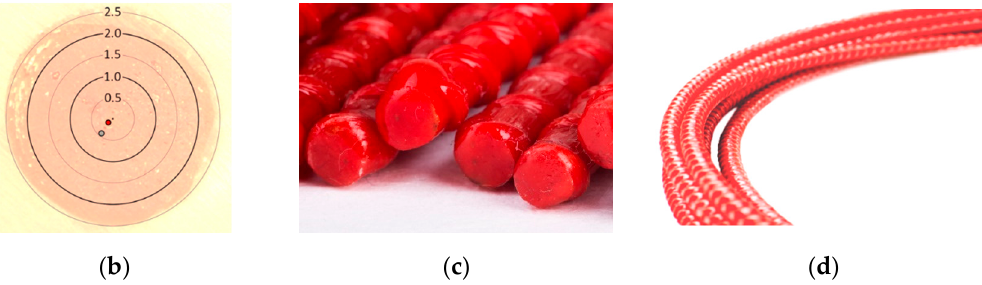
Figure 12. Example of stiff monolithic DFOS strain sensor: ( a ) cross-section; ( b ) microscopic view with the scale and marked optical fibres; ( c ) side view; ( d ) the view of the outer surface.